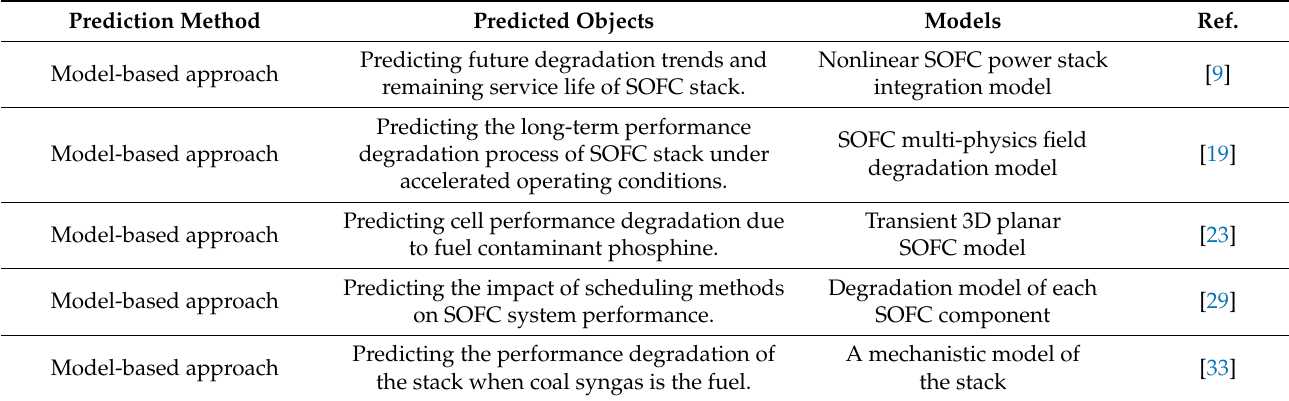
Table 2. Model-based study of SOFC degradation performance